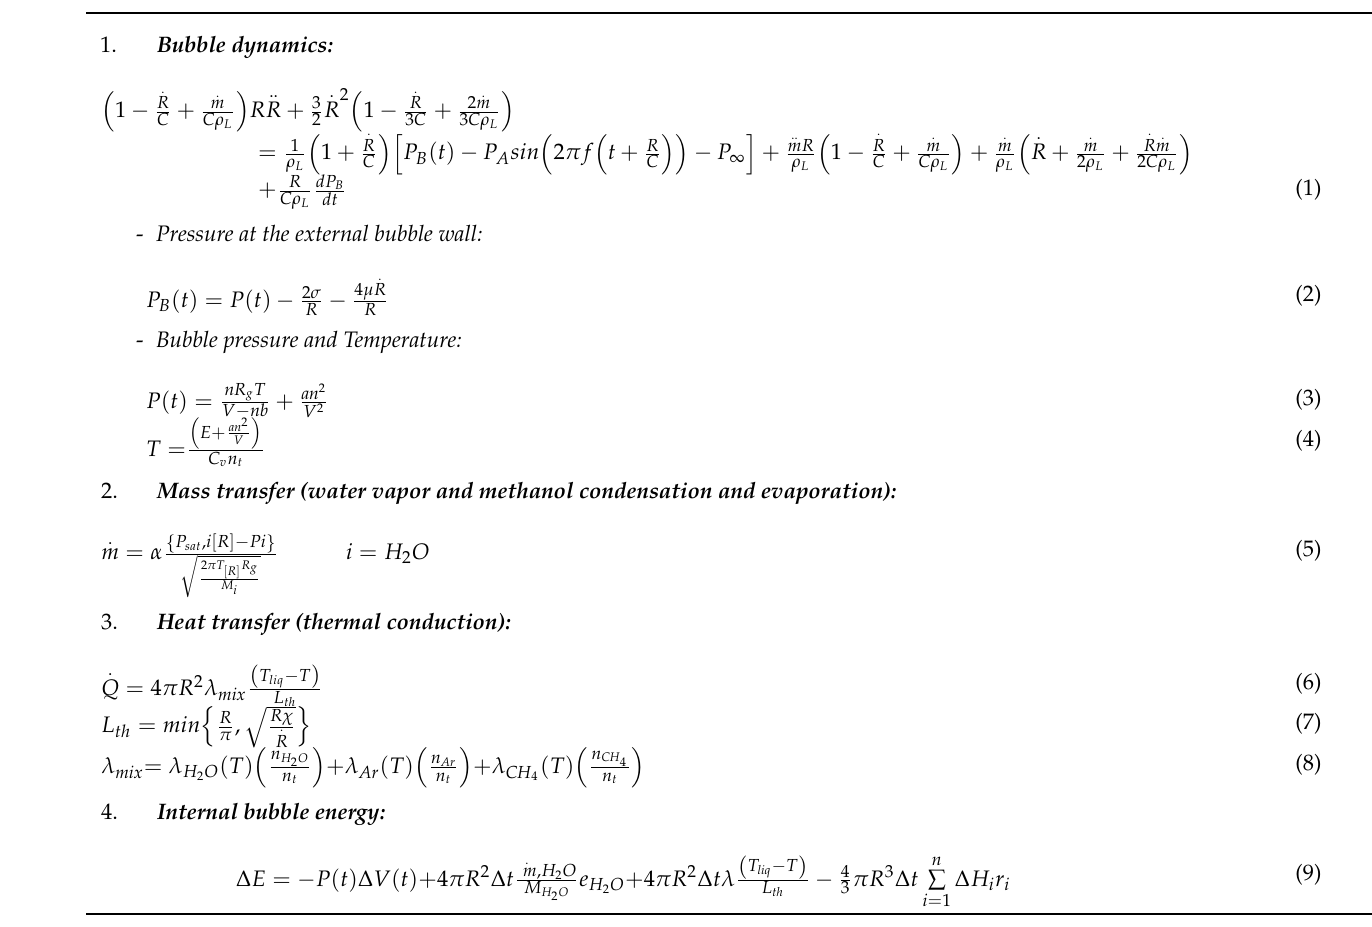
Table 1. Principal equations of the model (see detail in Refs. [23,24])